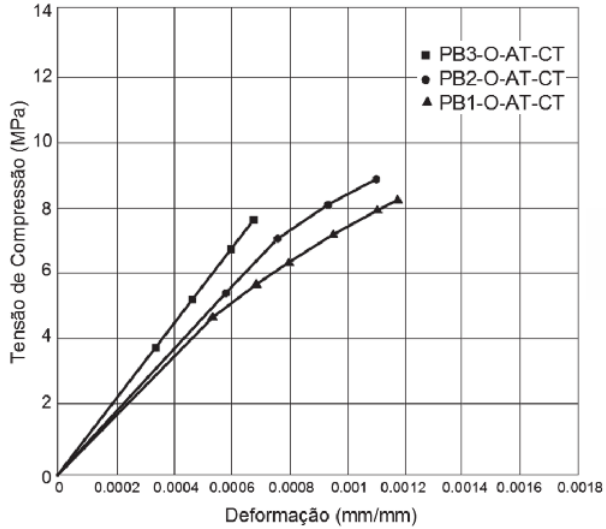
Figura 25, manteve-se linear aproximadamente até 60% da car- ga de ruptura, indicando que a colocação da cinta a meia altura da parede, a forma de assentamento, argamassamento parcial ou forma da curva tensão-deformação para paredes.